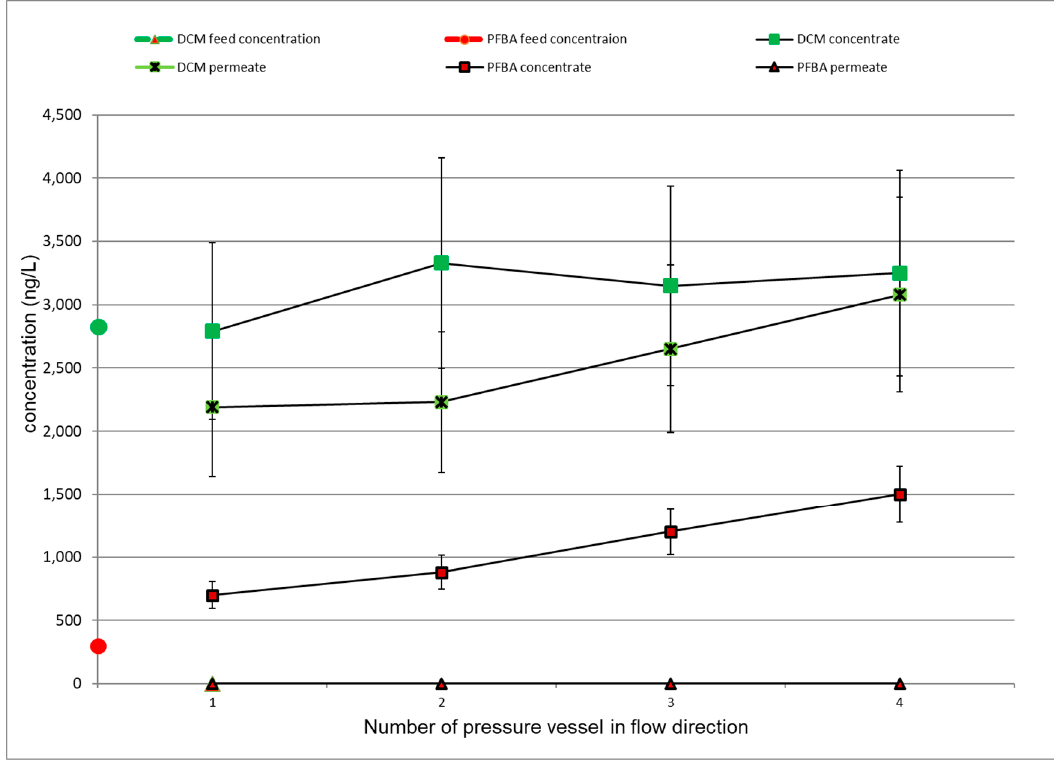
Figure 6. Internal plant concentration profiles for perfluorobutane carboxylic acid (PFBA) and dichloromethane (DCM) with estimated errors.